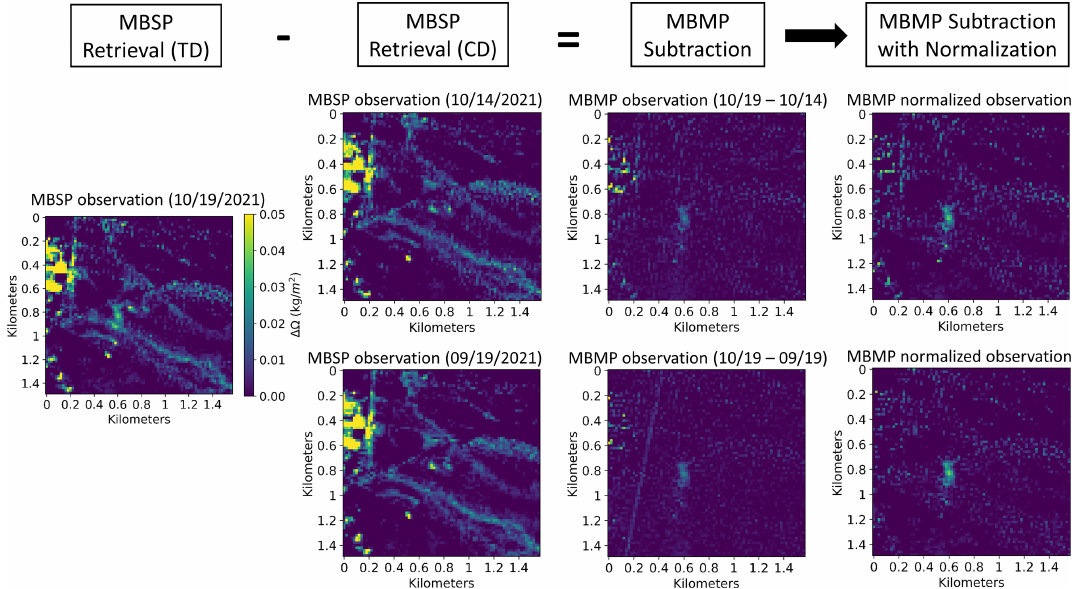
Figure 2. Examples of normalization. Here are two MBMP retrieval examples, one with 19 October 2021 as target date (TD) and 14 October 2021 as comparison date (CD) and another with 19 October 2021 as TD and 10 September 2021 as CD. In each example, we show MBMP plume observation without and with normalization (see figures of the third and fourth column from left). In both examples, the normalized MBMP retrieval shows more plume contrast with the background than the one without normalization. In the second example with 10 Septem- ber 2021 as CD, there is a particularly straight line artifact in the MBMP retrieval without normalization, and it is removed in the normalized MBMP retrieval. This illustrates the fact that normalization improves the effect of artifact removal by making MBSP retrievals of TD and CD conform to the same scale.